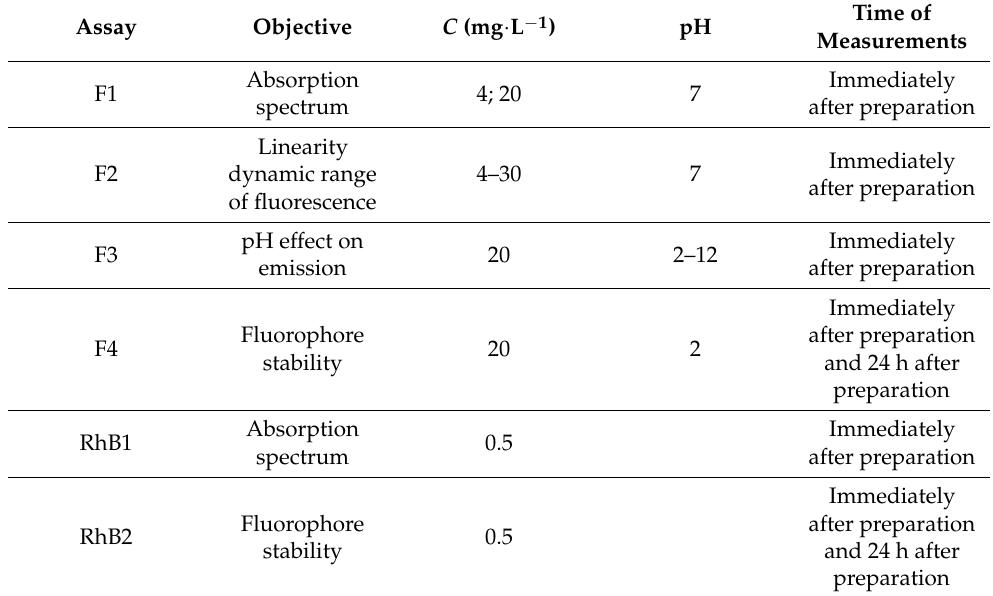
Table 4. Experimental conditions of AB-RPLIF and Oxi-RPLIF methods.